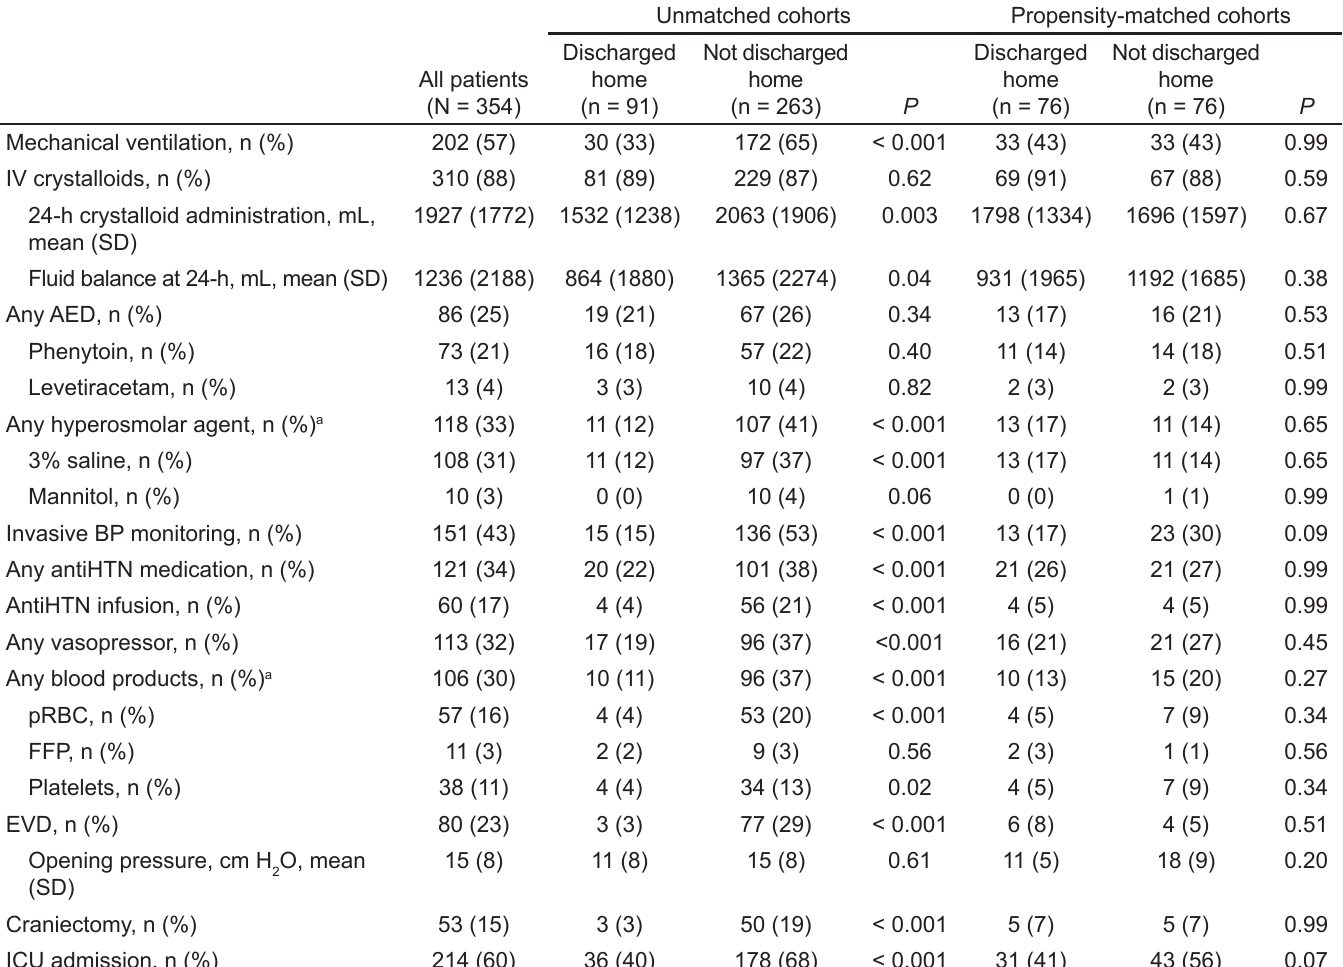
Table 2. Comparison of interventions provided in the first 24 hours of hospitalization by discharge location, matched and unmatched